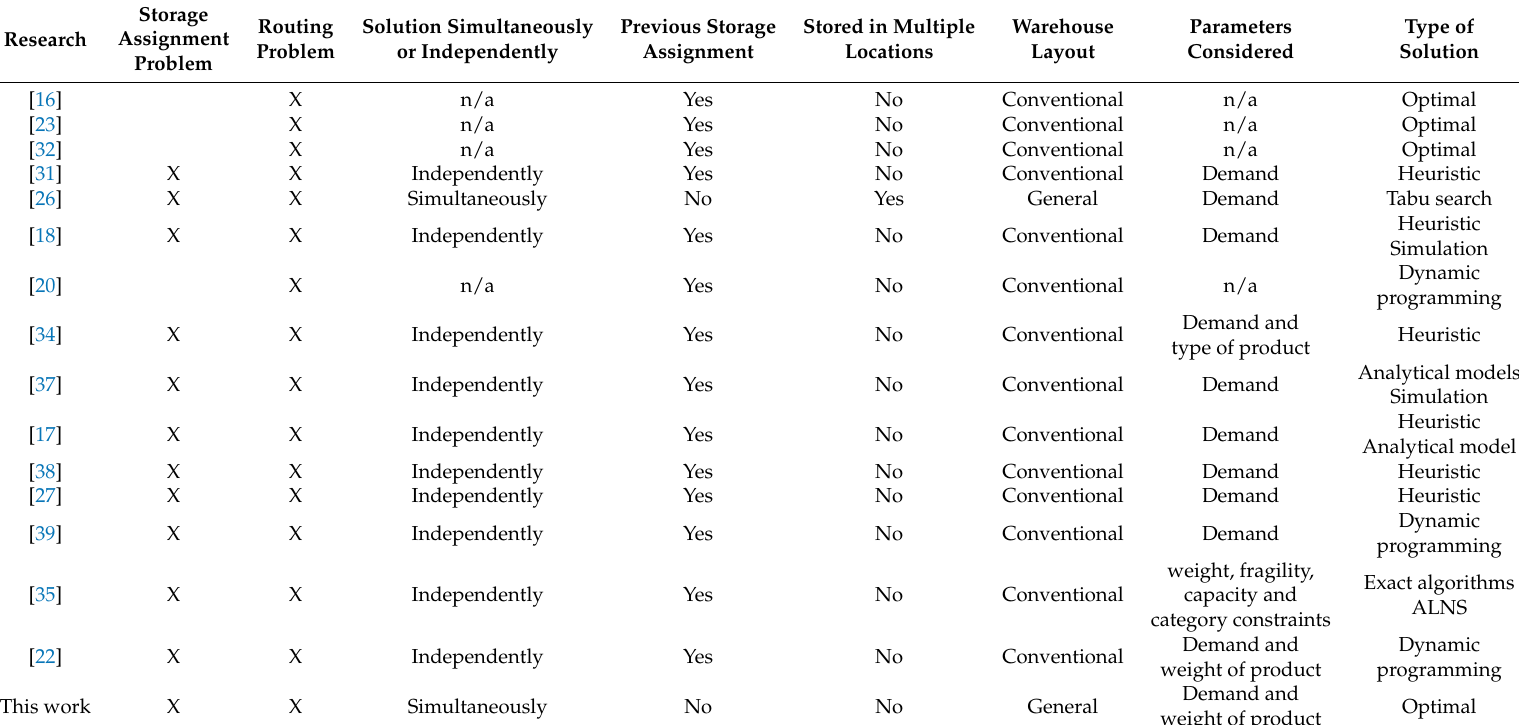
Table 1. Research